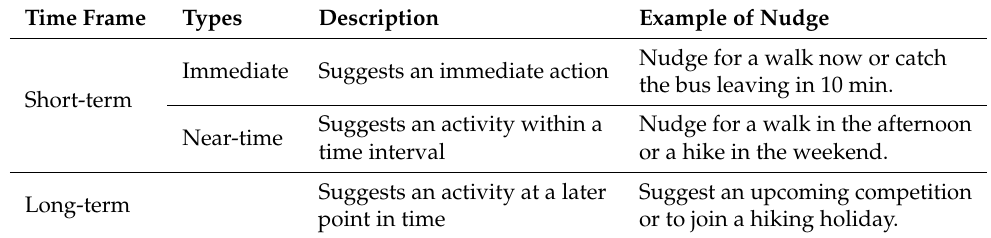
Table 4. Time frame for nudges.